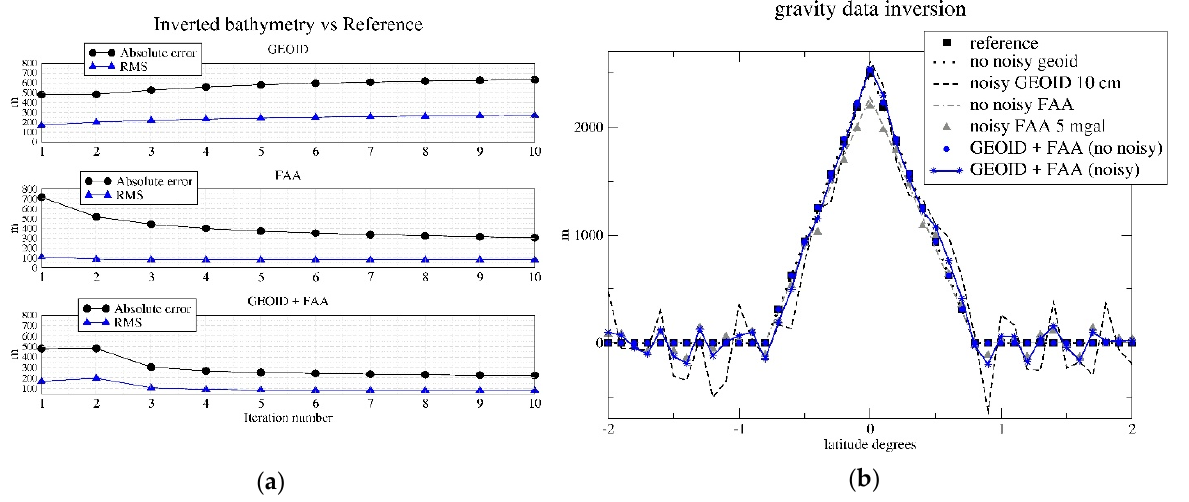
Figure 7. ( a ) Convergence (RMS and absolute error) of the inversion of noisy geoid heights (GEOID), free-air anomalies (FAA) and their combination (GEOID + FAA) using EKF; ( b ) profile of the reference and estimated bathymetry at iteration 10.